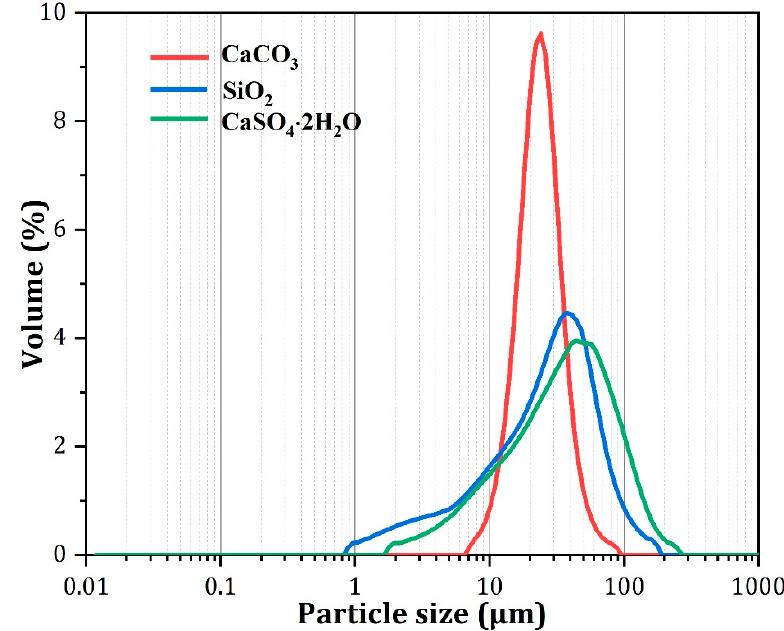
Figure 1. Particle size distribution curves for the raw materials.